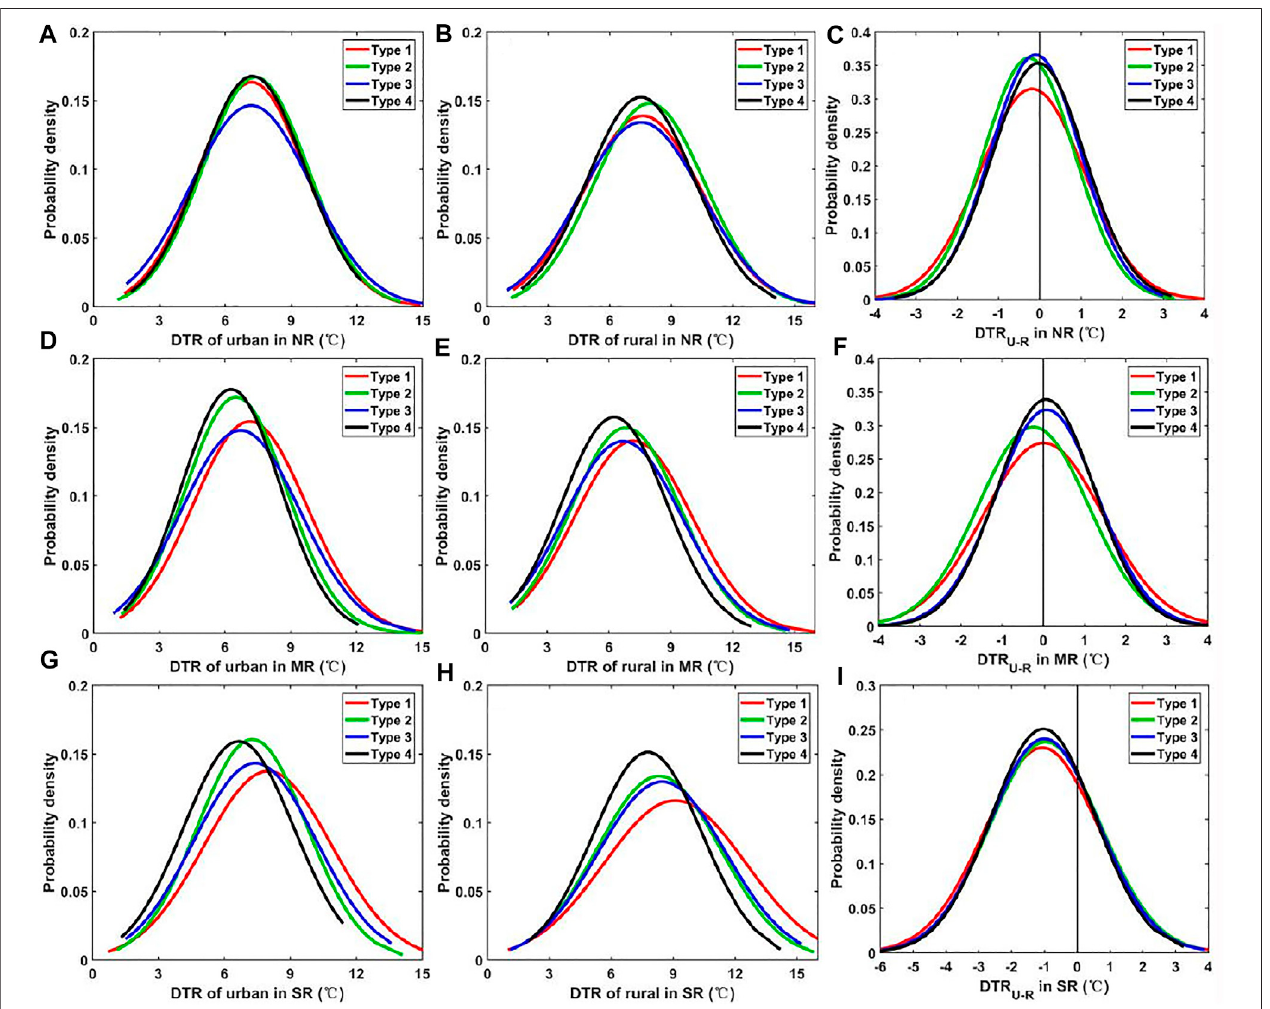
FIGURE10| ProbabilitydensitydistributionsoftheDTRin (A,D,G) urbanand (B,E,H) ruralareas,and (C,F,I) theirdifference(DTR U – R ),underfourSWPsinNR,MR and SR, respectively.